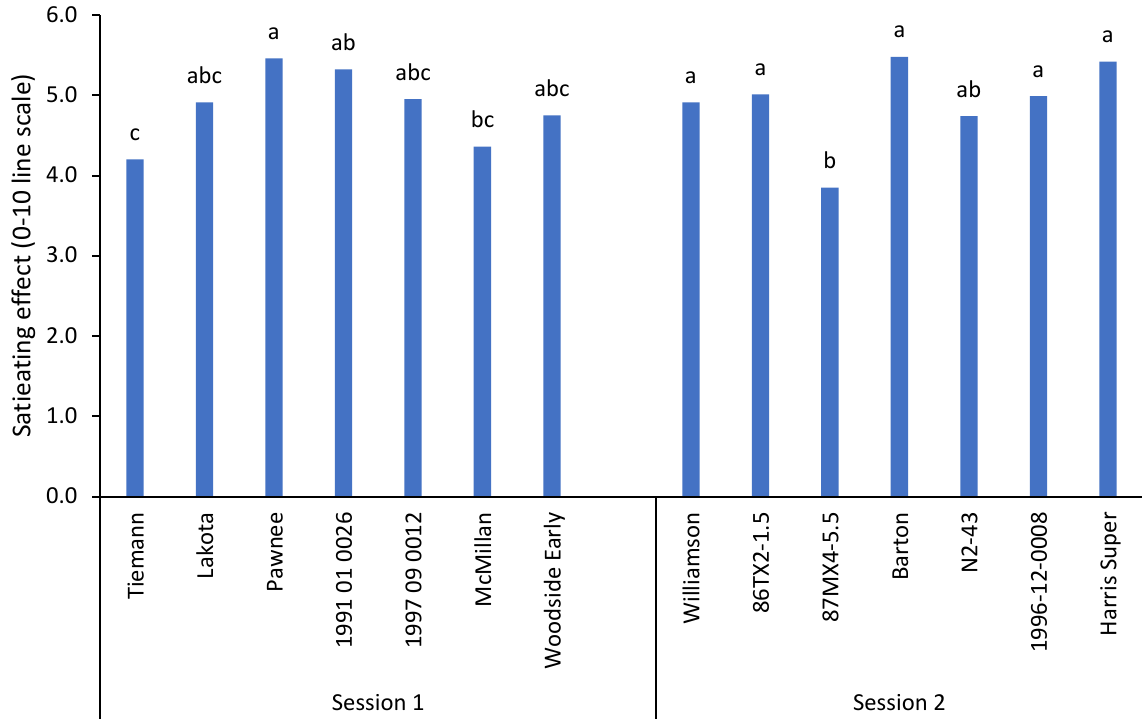
Figure 2. Consumer mean scores ( n = 99) for satiating effects of 14 pecan samples on a 0–10 line scale. Different letters (a–c) within attributes indicate significant differences between samples according to one-way ANOVA and Tukey’s HSD test.